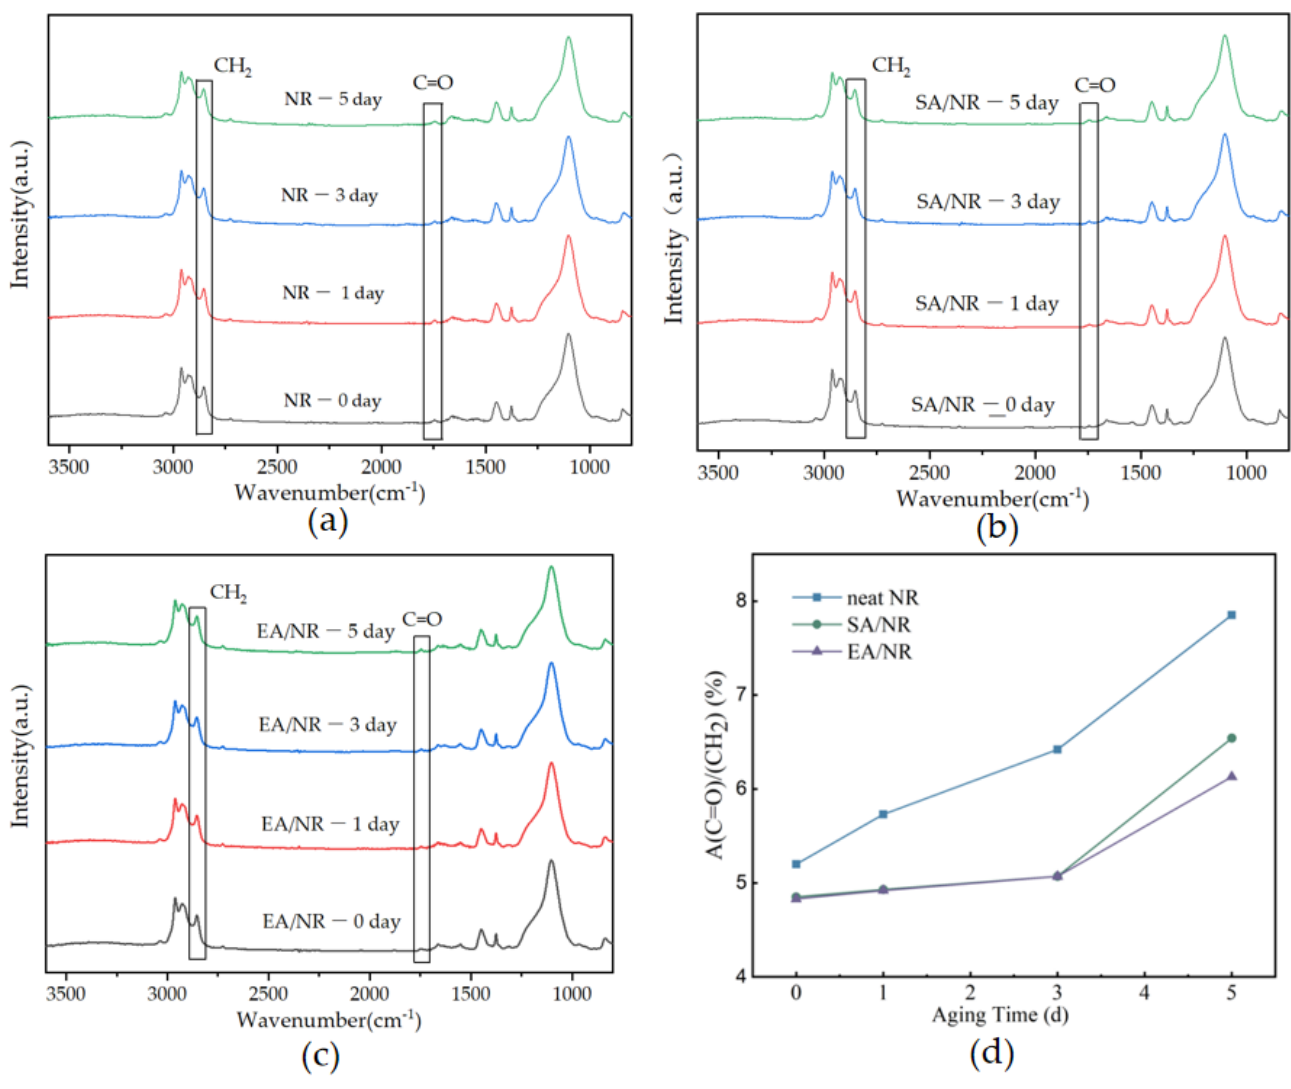
Figure 8. ( a – c ) The FT-IR spectra of NR composite before aging and after aging 1, 3, and 5 days and ( d ) the carbonyl increase ratio of A (C=O) /A (CH2) for NR and AO/NR composites at 100 °C.